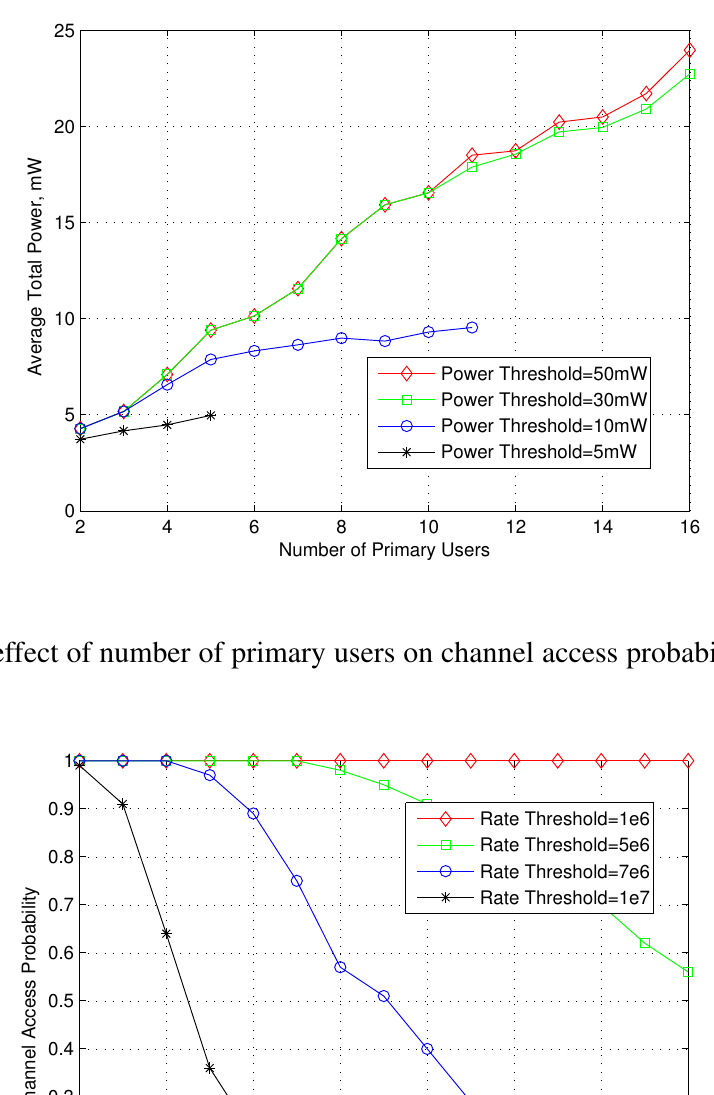
Figure 6. The variation of average total subcarrier power with number of primary users for different power thresholds.